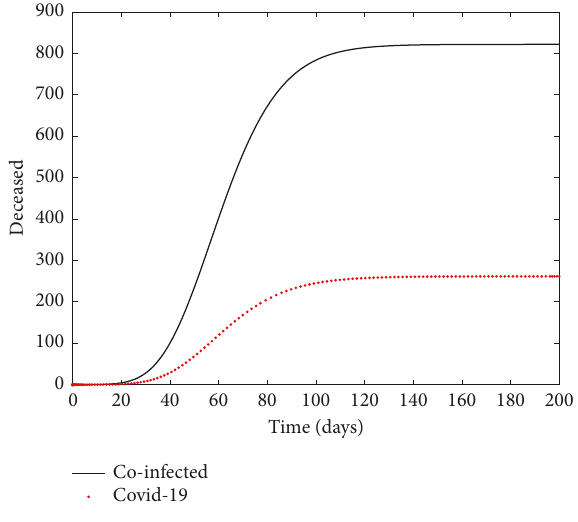
Figure 10: Deceased COVID-19